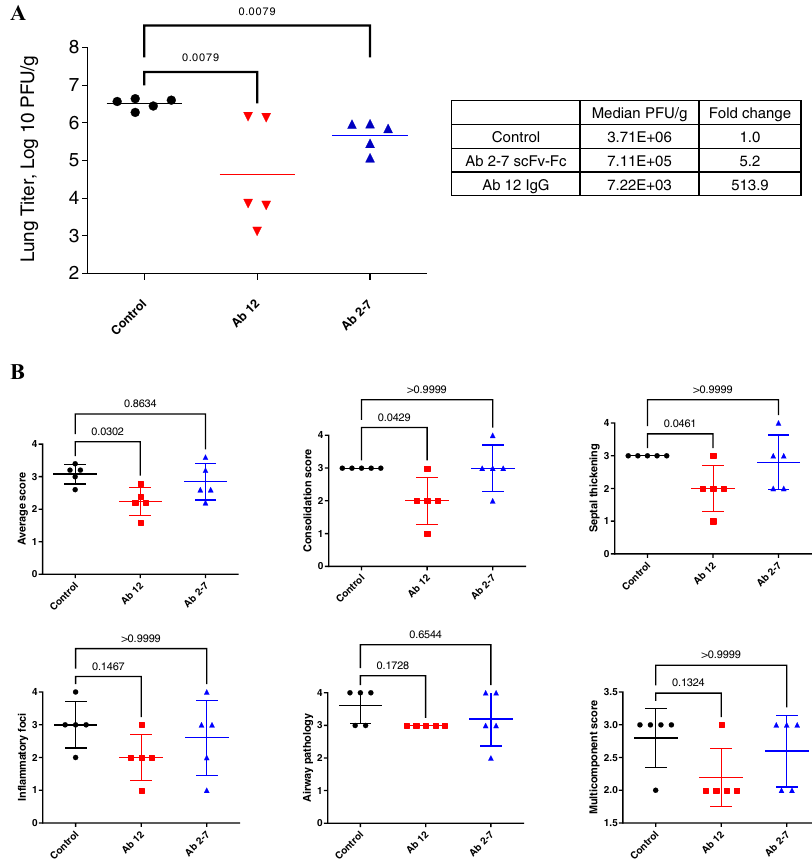
Fig. 4 | Therapeutic ef fi cacy of Ab 12 IgG and Ab 2-7 scFv-Fc in Syrian golden hamstermodel.A TherapeutictreatmentofSyriangoldenhamsterspost-infection with Ab 12 IgG or Ab 2-7 scFv-Fc leads to a 513.9- and 5.2-fold reduction of viral loads, respectively, compared to control (PBS) treated animals B Pathology scores for animals treated with PBS, Ab 12 IgG, or Ab 2-7 scFv-Fc. Signi fi cant reduction in overall, consolidation, and septal thickening scores were seen for Ab 12 treatment.